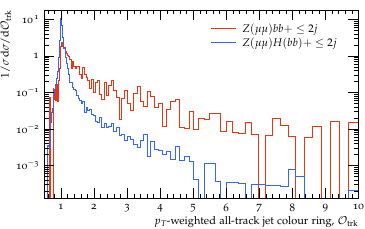
Figure 3: Alternative track-jet p weighted colour ring. This version does not require T the presence of three track-jets in the event and improves its